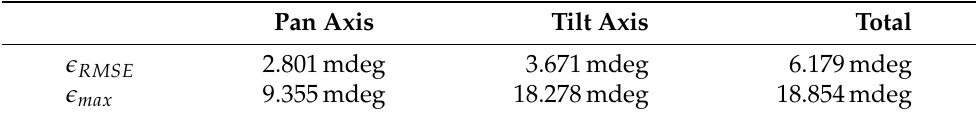
Table 4. This table highlights the individual pointing errors of each axis as well as the overall pointing error. Both the RMSE ( (cid:101) RMSE ) and the maximum pointing error ( (cid:101) max ) are shown. Pan